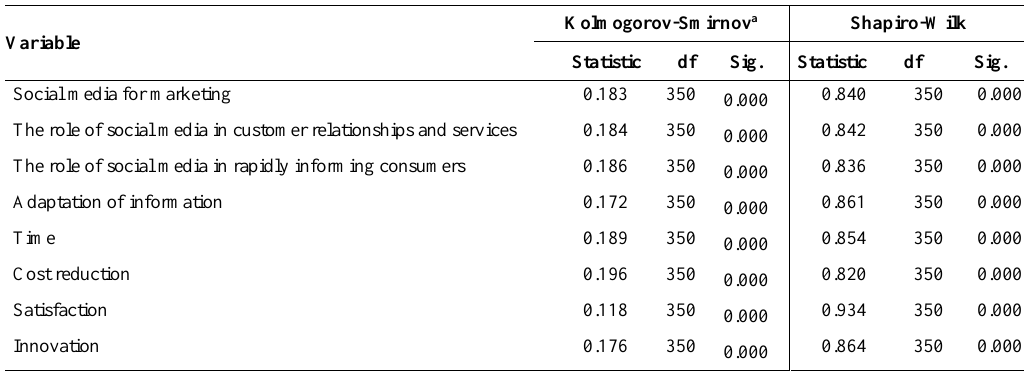
Table 5. Test of